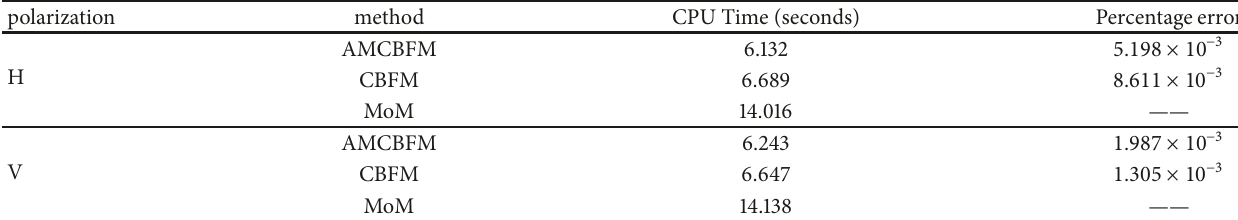
Table 1: The CPU time and the percentage error of the AMCBFM and the CBFM.